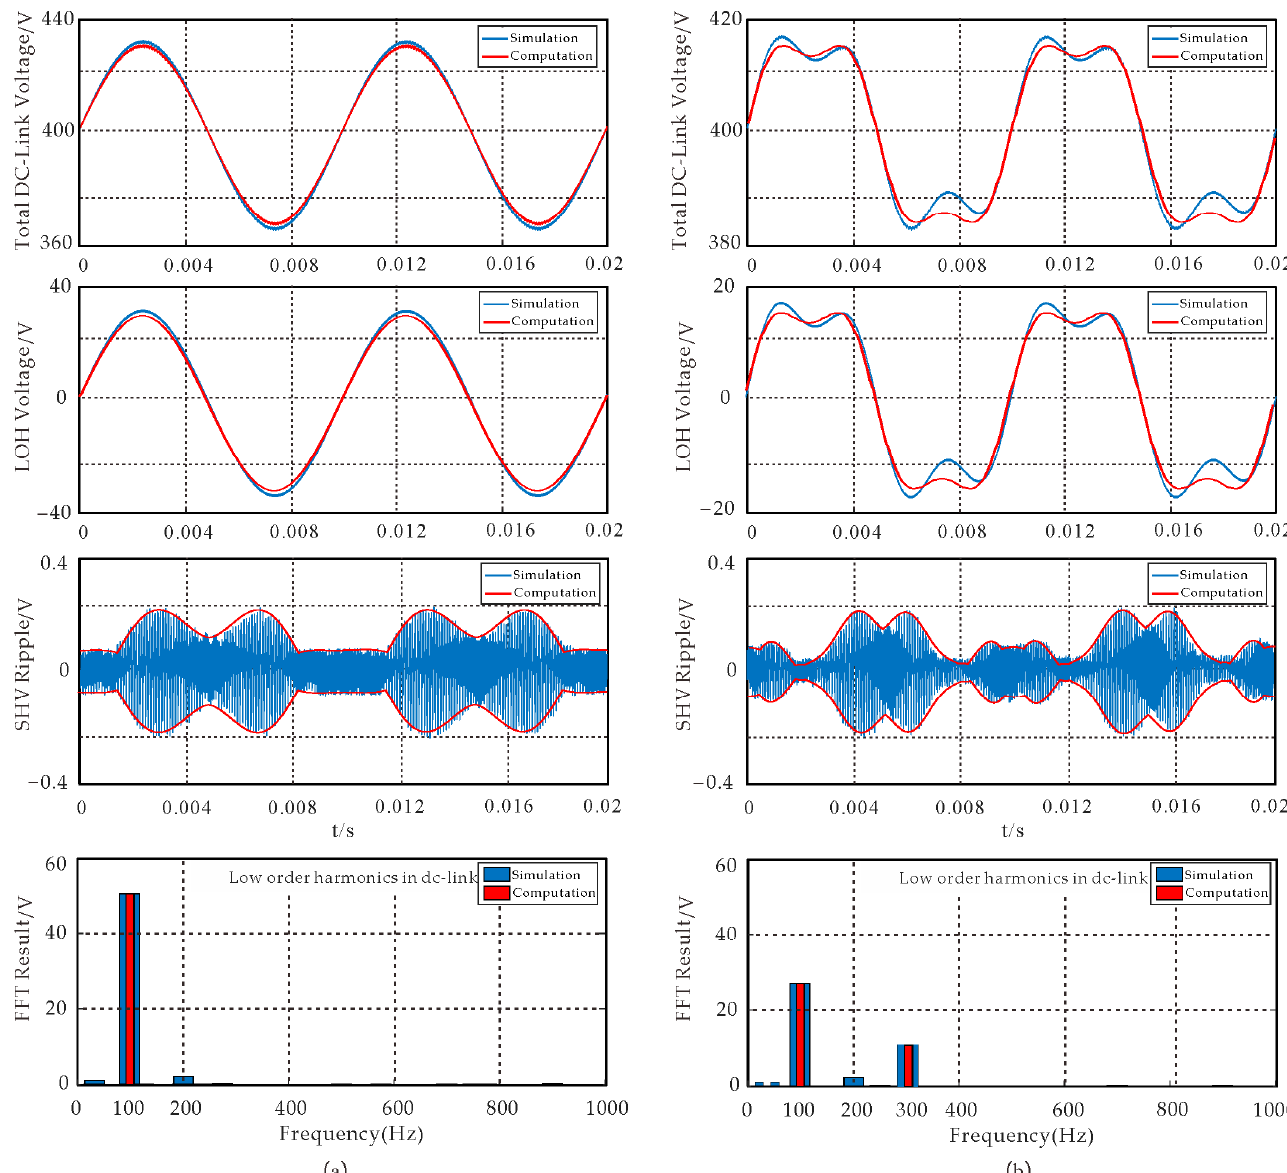
Figure 6. Simulation results of the total dc-link voltage ripple: ( a ) AC link currents contain − 1st (15A, 0); ( b ) AC link currents contain − 1st (10A, 0) and − 5th (10A, 0).